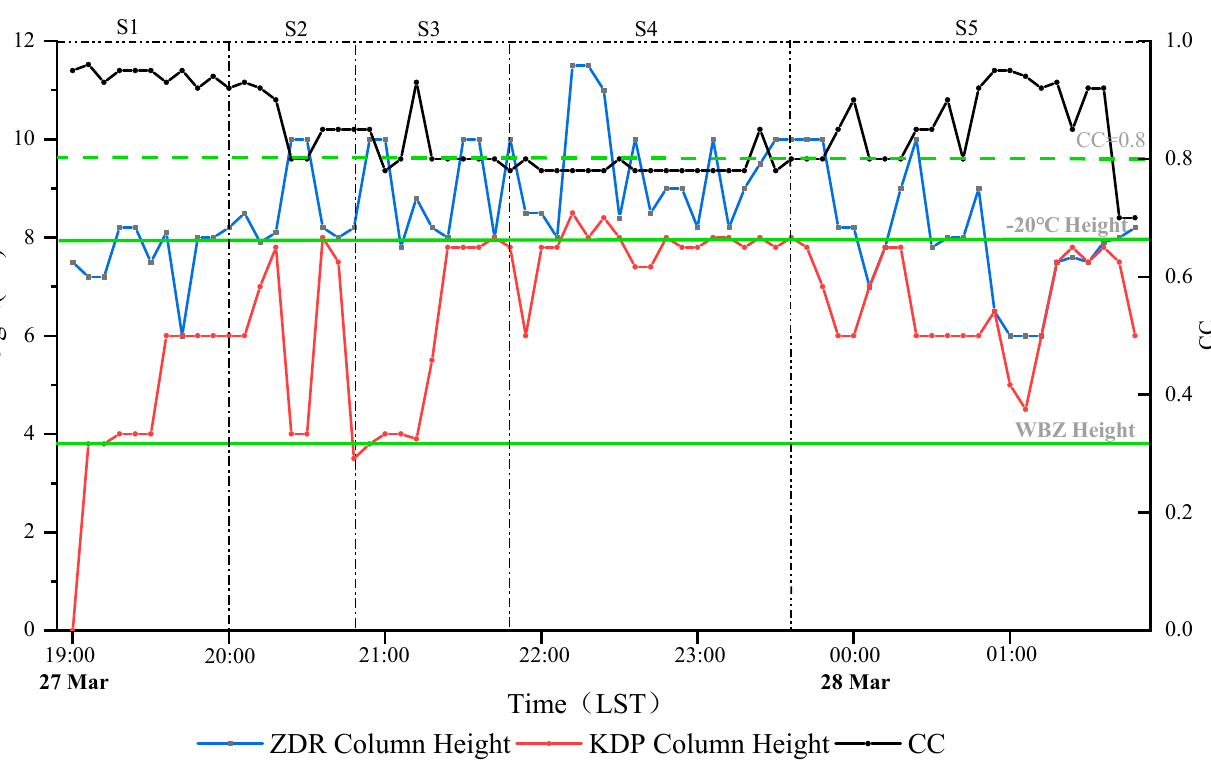
Figure 10. Time-dependent changes in the ZDR column (blue line), KDP column (red line), and CC (black line) inside the hailstorm. WBZ and − 20 °C layer heights are marked with green solid lines, and green dotted lines indicate that the height of CC = 0.8.